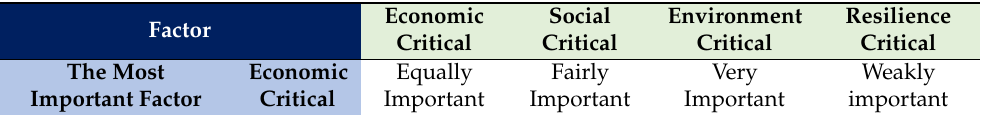
Figure 5. Results for economic, social, environmental, and resilient criticality of PA1 in GP. Table 10. The linguistic terms describing the fuzzy preferences of the most important factor over all the factors.